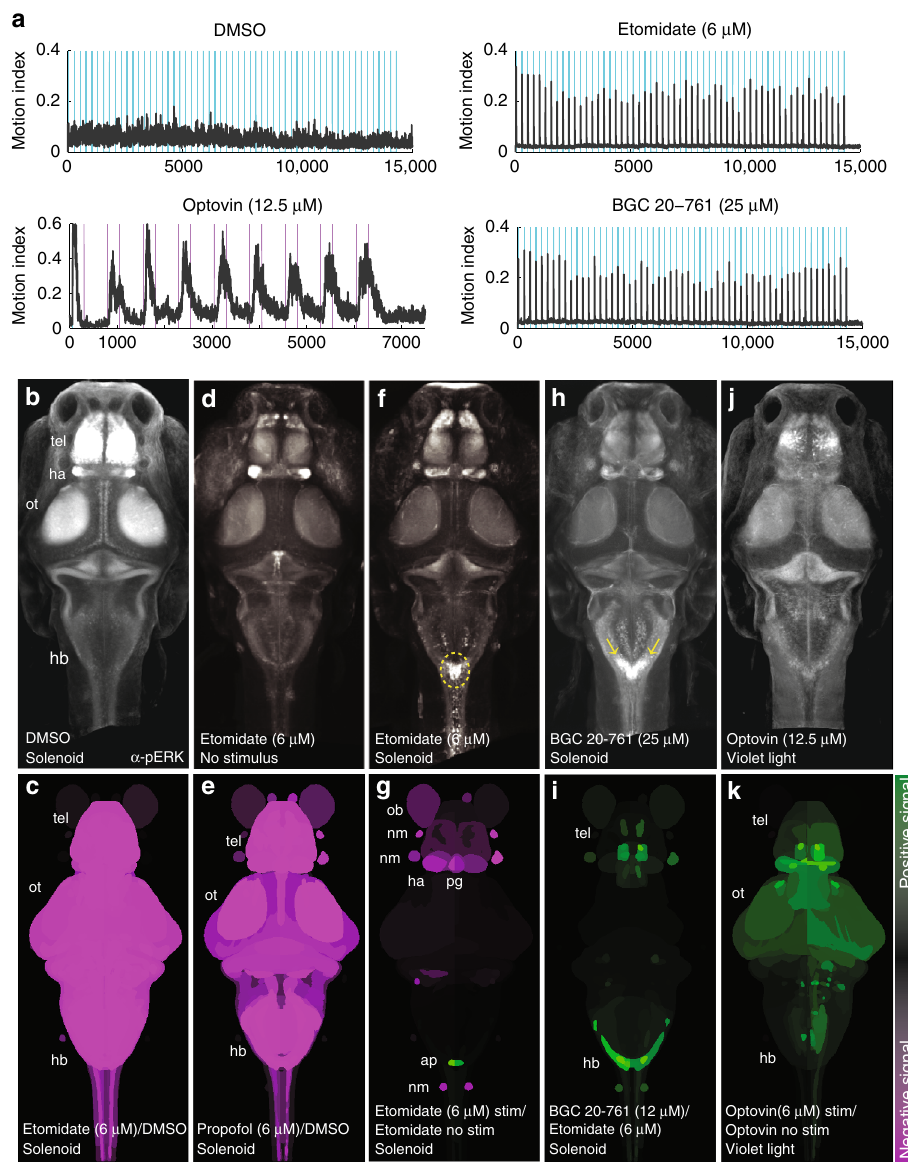
Fig. 5 Hit compounds activate hindbrain neurons. Animals were exposed to the indicated drugs and stimuli and analyzed for pERK levels as a readout of neuronal activity. a Plots showing motor activity ( y -axis) over time ( x -axis) for animals treated with the indicated compounds ( n = 25 – 50 larvae) in response to the indicated acoustic (blue) or violet light (purple) stimuli. b , d , f , h , j Confocal projections showing the average fl uorescent intensity of image registered larval brains stained with α -pERK ( n = 10 larvae/condition). Larvae were treated with the indicated compounds and exposed to the low- amplitude acoustic stimulus once every 10 s for 10 min, except for ( b , no stimulus) and ( f , violet light exposure). c , e , g , i , k Brain activity maps showing signi fi cant Δ pERK signals using the Z-brain online reference tool ( n = 5 – 10 animals/condition). The heatmap indicates positive (green), negative (purple), and nonsigni fi cant (black) changes in pERK labeling (P < 0.0005, Mann – Whitney U test). All activity maps are comparisons between the indicated treatment conditions. Abbreviations: tel, telencephalon; ot, optic tectum; hb, hindbrain; ob, olfactory bulb; nm, neuromast; ap, area postrema;